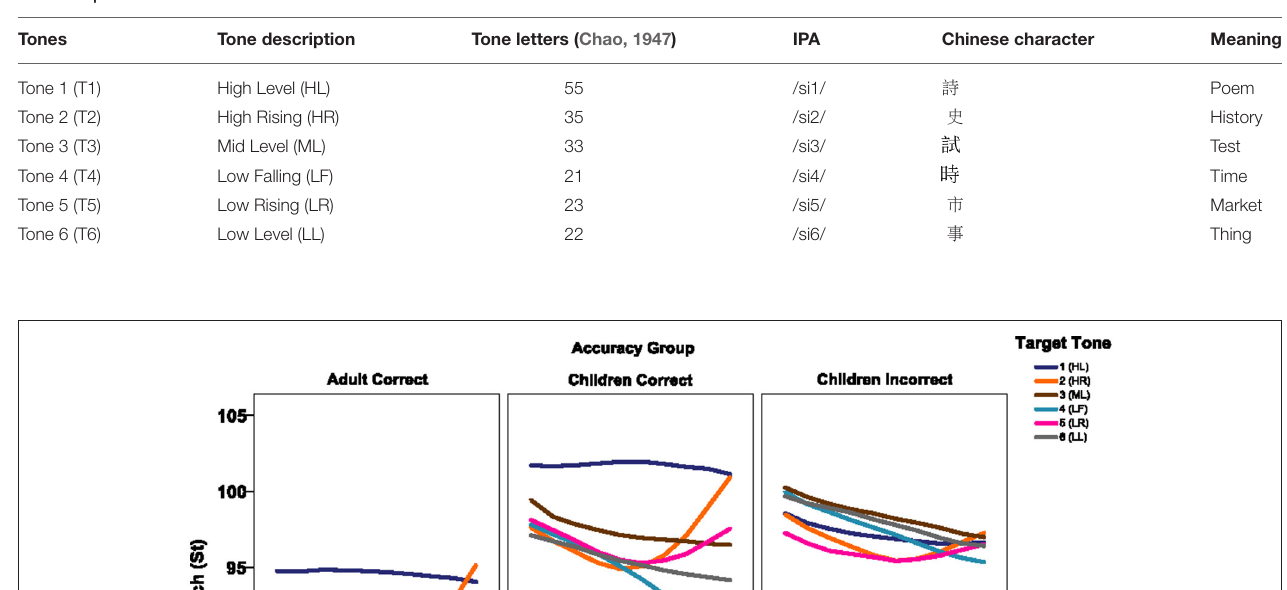
TABLE 1 | The six tones in Cantonese.